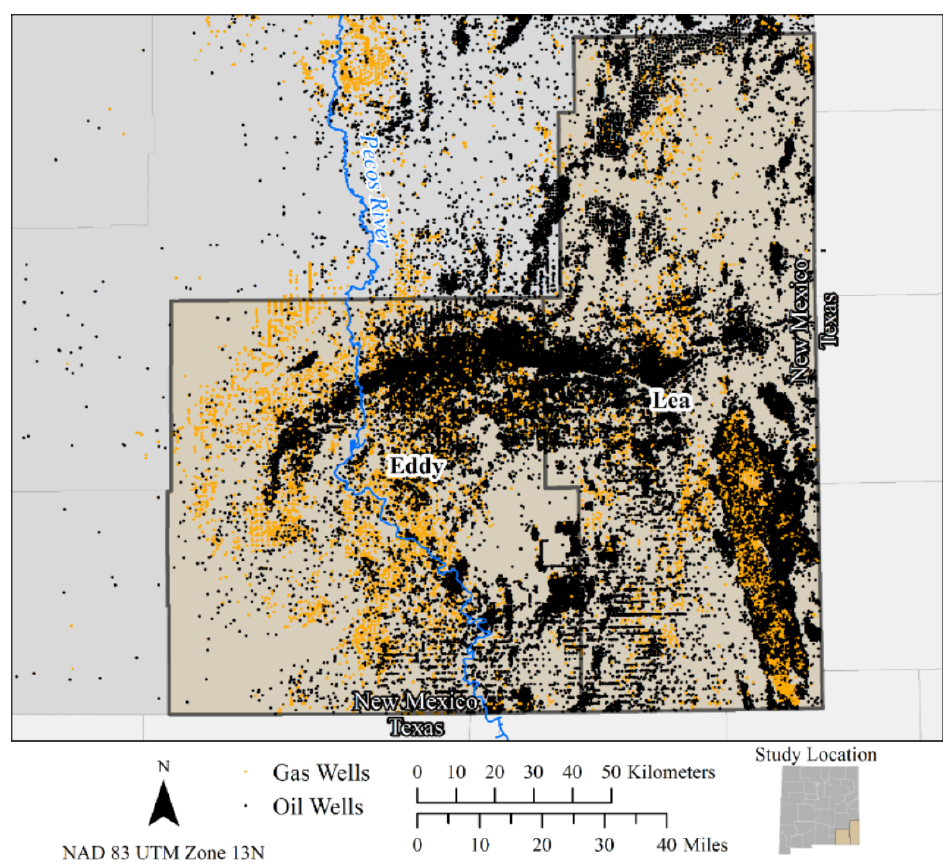
Figure 2. Oil and gas production in Eddy and Lea counties, New